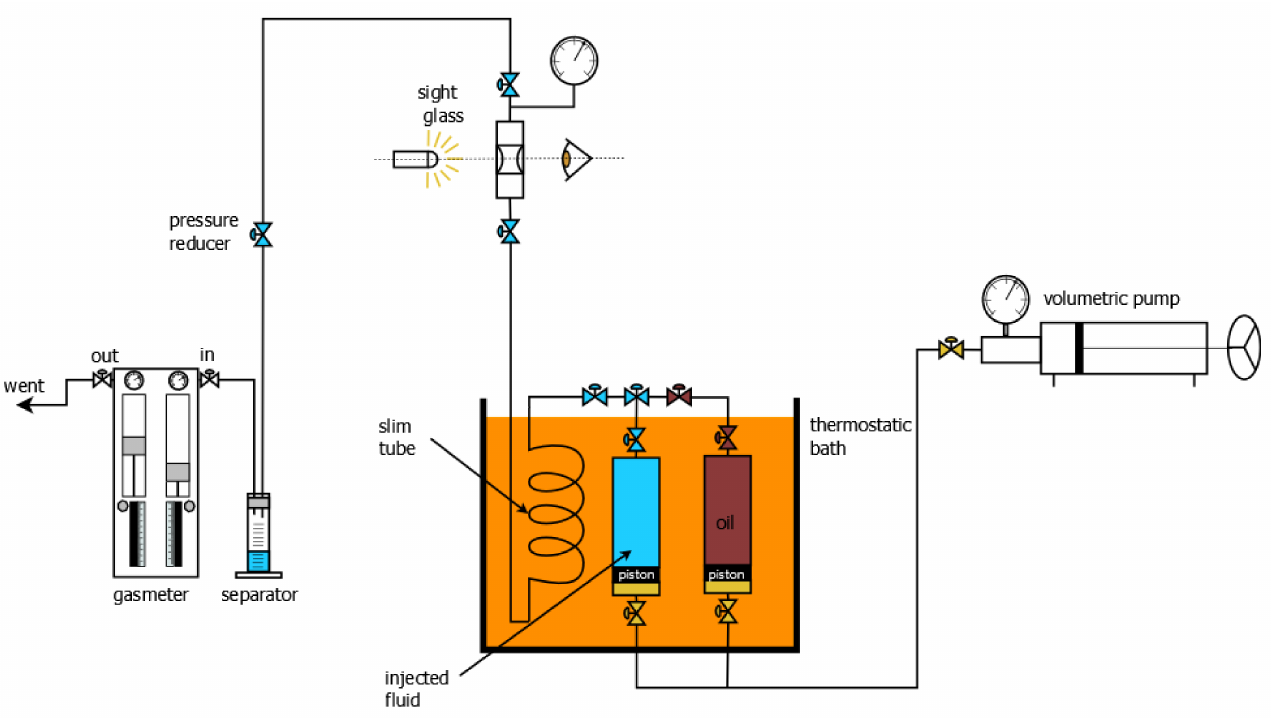
Figure 3. Schematic diagram of the slim tube